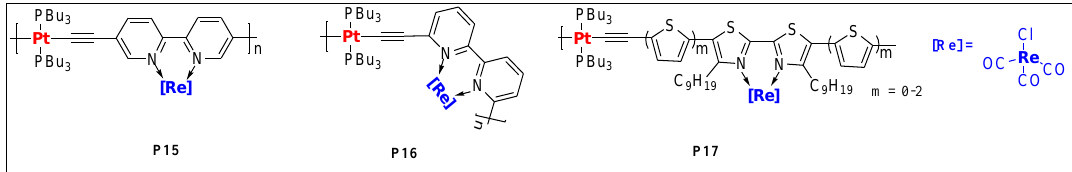
Figure 10. Re(I)-coordinated Pt(II) poly(metalla-ynes). Table 3. Photoluminescence (PL) data of selected heterometallic poly(metalla-ynes) P12 – P19 .